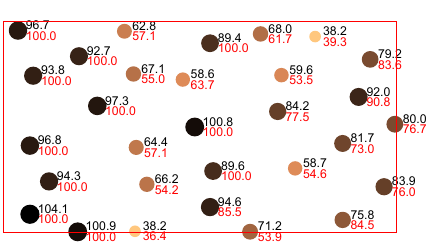
Figure 5. Comparing the wind-turbine power generation obtained from LES data (black numbers) and Jensen model (red numbers). Turbine locations are marked with coloured disk: size and colour scale by relative power. Plot boundary (red box) corresponds to boundaries of domain (cid:127) (see Fig. 1).